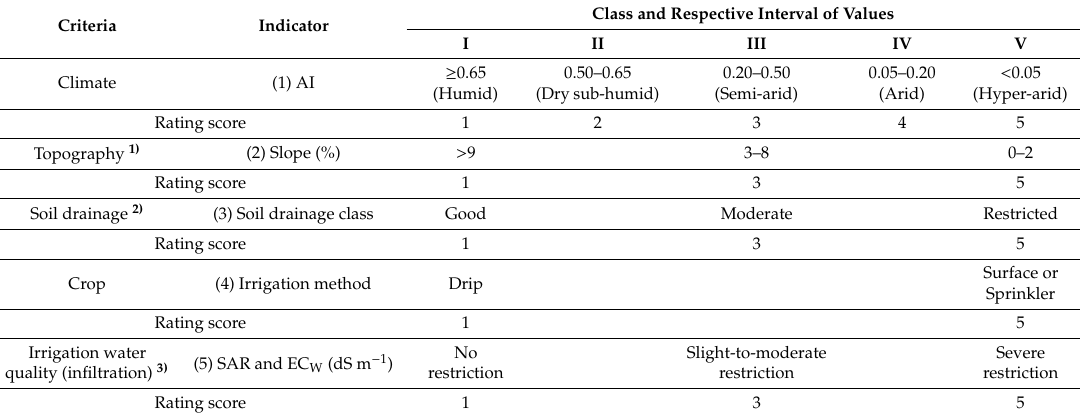
Table 6. Criteria, indicators, class limits and their rating score to evaluate the risk of soil sodification in irrigation areas in the Sodification Risk index